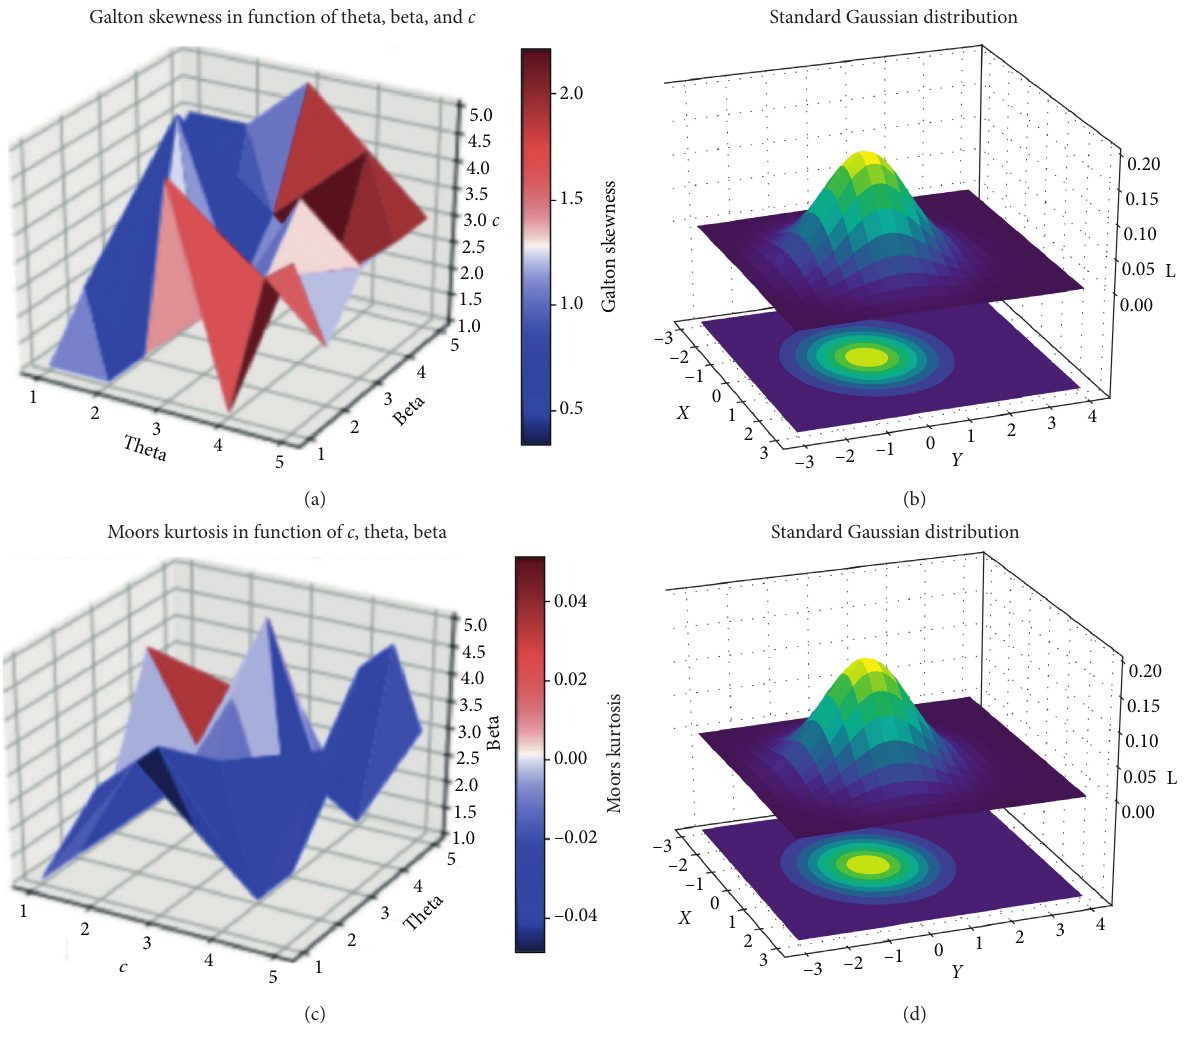
Figure 5: Galton skewness and Moors kurtosis of GWL for different sets of parameter